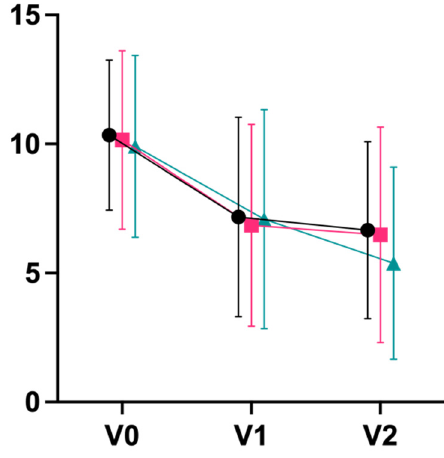
Figure 7. Mindfulness FMI (Mean ± SD).